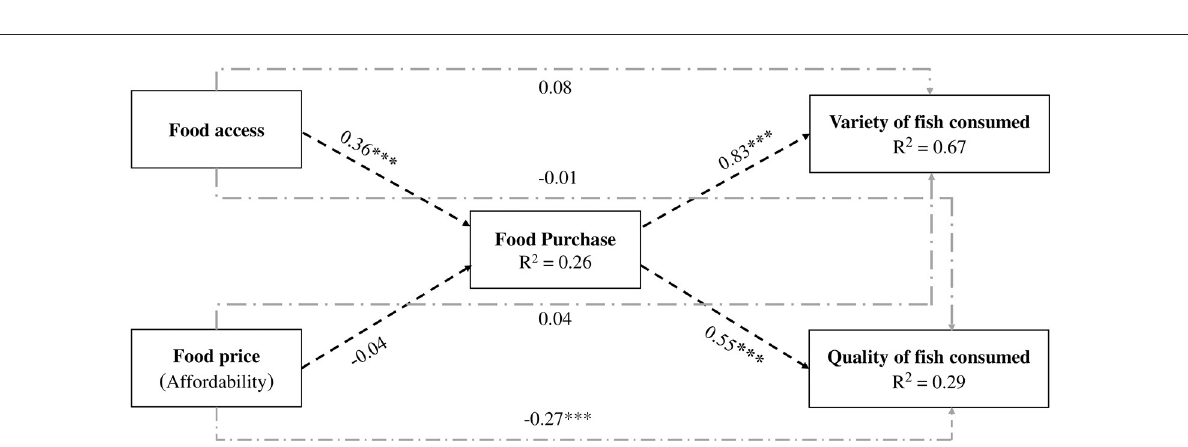
FIGURE4 Extended model with standardized coefficients (asterisk (*) showing statistically significance at p < 0.001). Reasonable fits of the model indicated by Chi-square = 22.590 ( df = 4), p < 0.001, Comparative Fit Index (CFI) 0.954, Tucker-Lewis Index (TLI) 0.965, Root Mean Square Error of Approximation (RMSEA) 0.089, 90% CI (0.056, 0.129), Standardized Root Mean Square Residual (SRMR) 0.021. Model adjusted for age, gender, education, and HCI. Long dash dotted line shows the direct